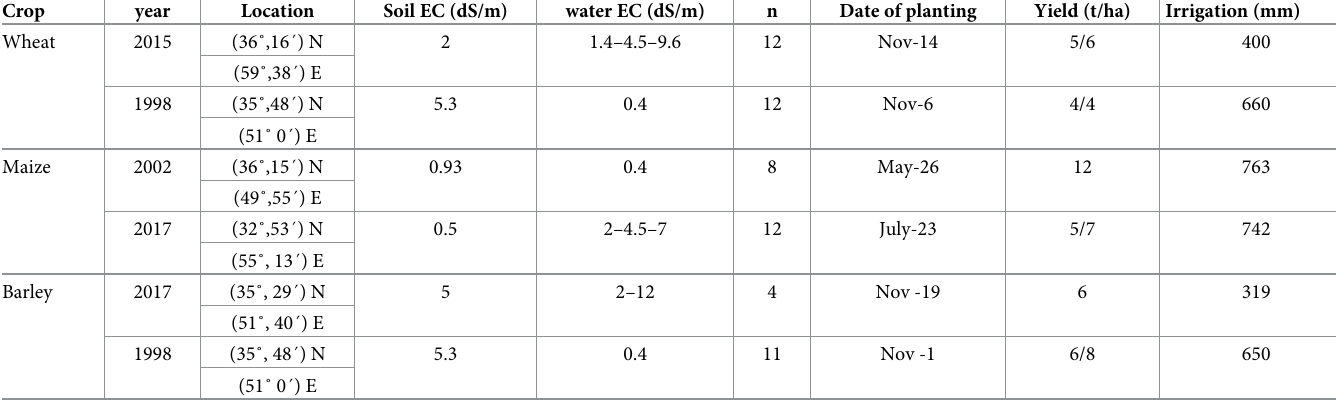
Table 3. Experimental data sets used in calibration and validation of AquaCrop with information: Location, year, date of planting, irrigation and yield in first level of salinity.